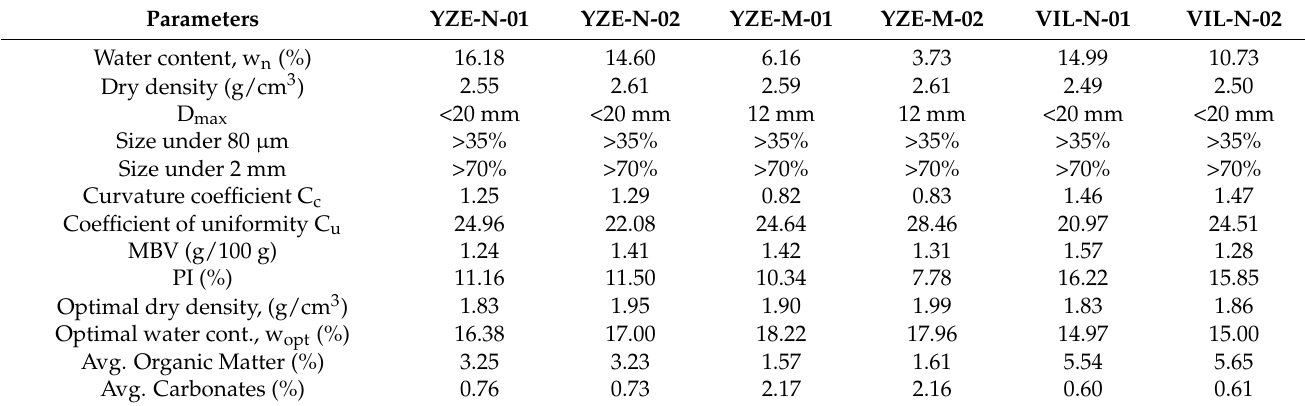
Table 5. Geotechnical characterization of each trench cuttings.